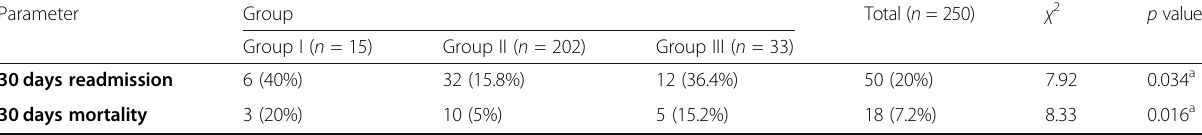
Table 8 Readmission and mortality among all studied groups Parameter Group Total ( n =